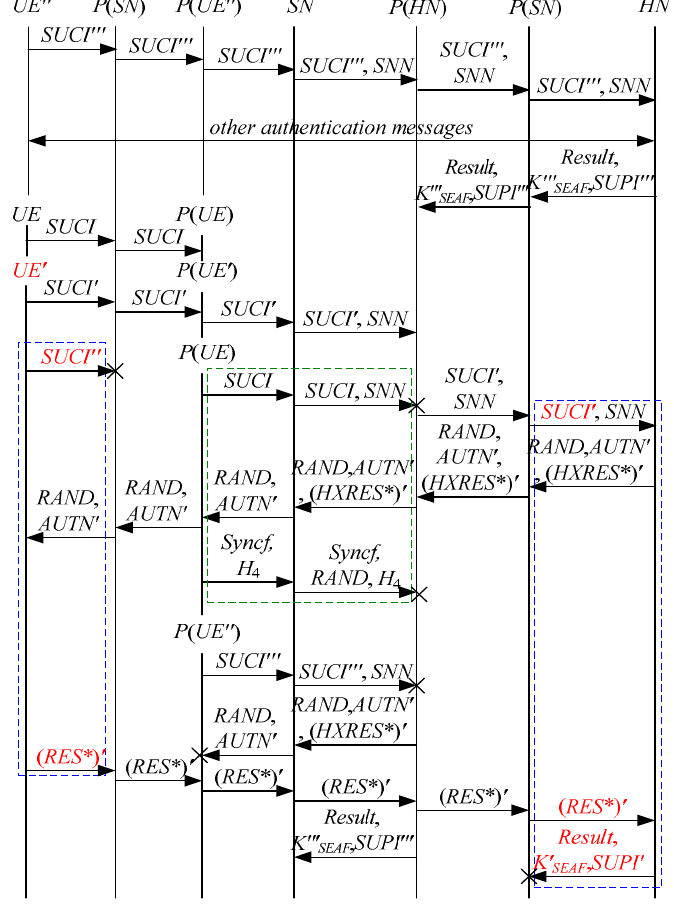
Figure 17. The sixteenth attack scenario of the 5G AKA protocol.